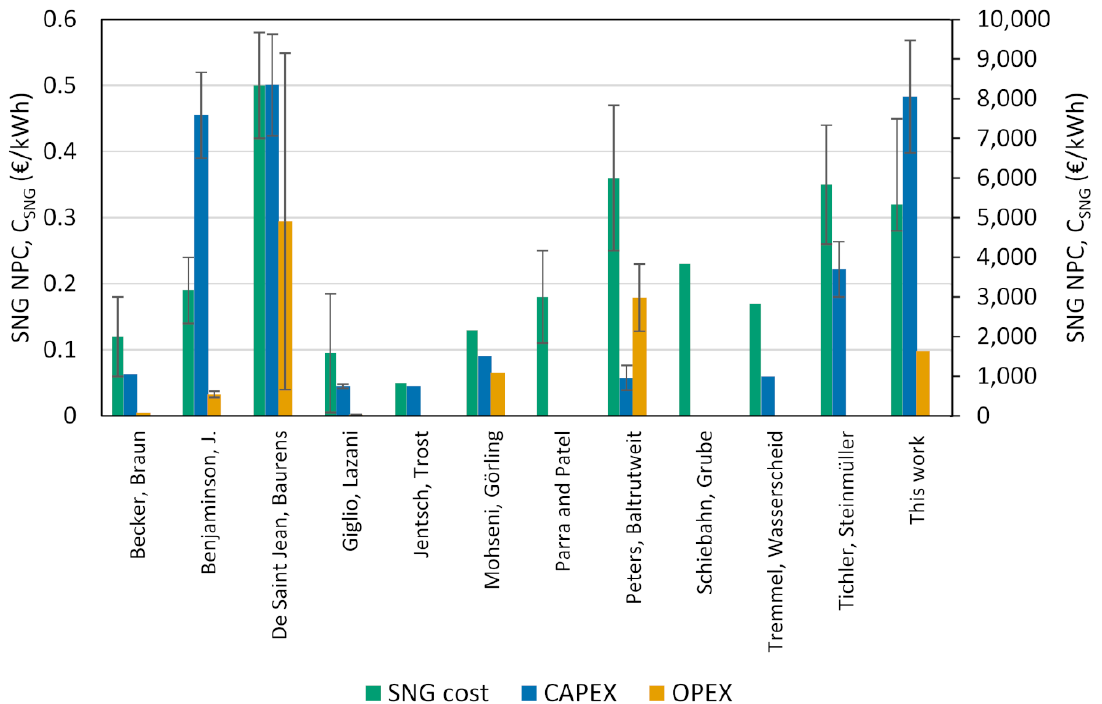
Figure 8. Literature comparison SNG, CAPEX and OPEX. Expenses not shown in the figure could not be calculated in € /kW from the available information. For further information refer to Supple- mentary Materials Section S6. Examined works include Becker, et al. [68], Benjaminsson, et al. [8], De Saint Jean, et al. [10], Giglio, et al. [64], Jentsch, et al. [65], Mohseni, et al. [66], Parra and Patel [18], Schiebahn, et al. [15] Peters, et al. [26], Tremel, et al. [14], Tichler, et al.